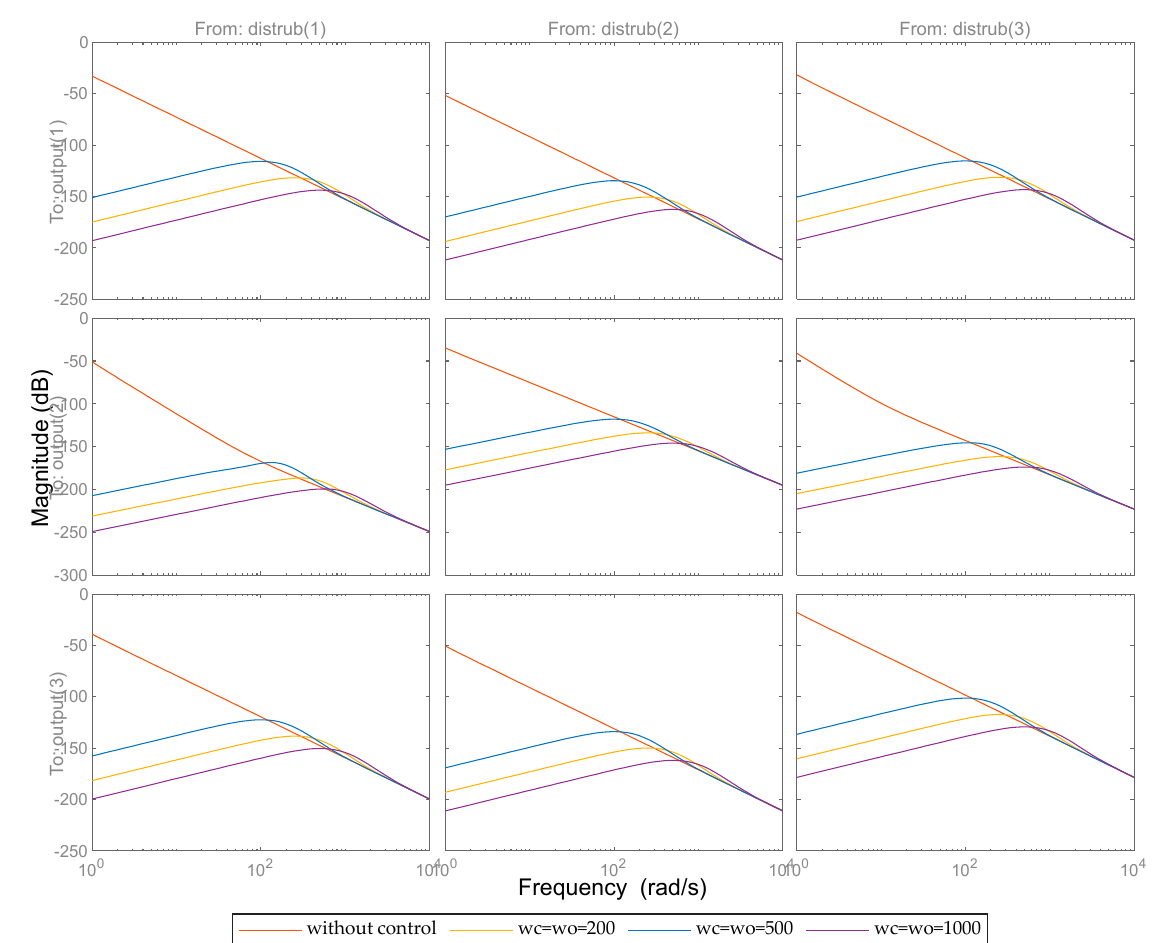
Figure 8. The frequency response from the base to the payload.